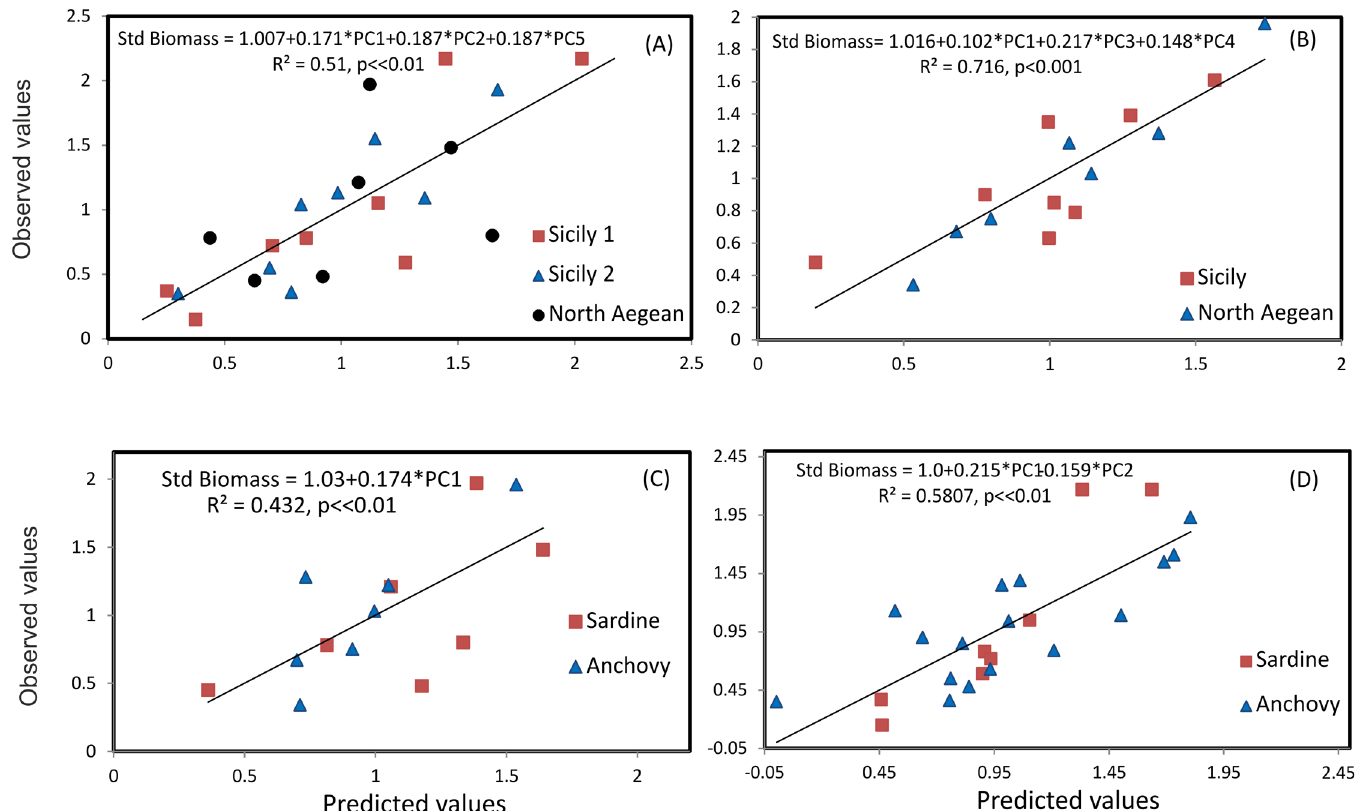
Fig 9. Observed vs predicted values for multiple regression models of standardized fish biomass on PCA axes scores, per species and area: a) pooled anchovy data from both areas; b) pooled sardine data from both areas; c) pooled anchovy and sardine data from the North Aegean Sea and d) pooled anchovy and sardine data from the Strait of Sicily. The estimated equation in each case is also